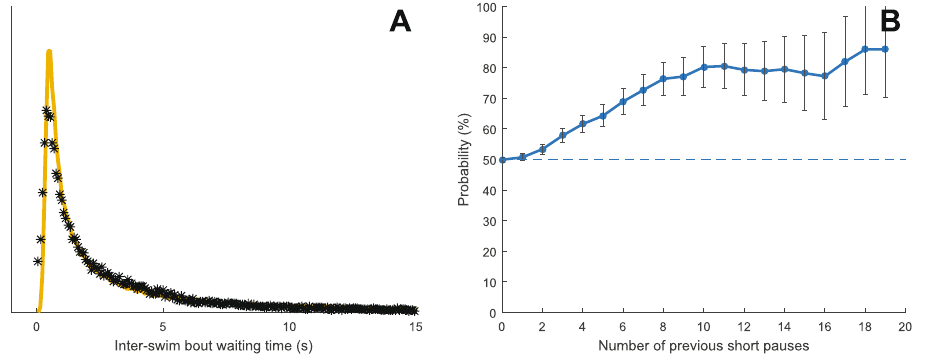
Figure 3. The organization of inter-bout waiting times. ( A ) The distribution of inter-bout waiting times (total n = ∼ 120,000), yellow line denotes fitting of the Ornstein–Uhlenbeck model to experimental data and asterisks show binning density. ( B ) The probability of observing a short waiting time, given that the previous waiting times were also short increases with the number of similar waiting times observed in a row (short = the shortest 50% of the total amount of waiting times observed in each larva). Error bars denote